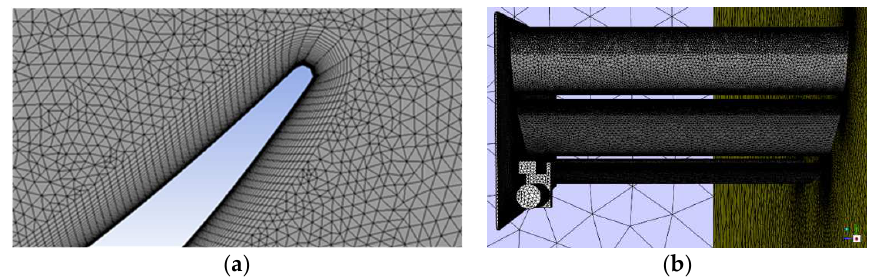
Figure 4. Example of the mesh detail: ( a ) trailing edge of 2D profile and ( b ) 3D rear wing with actuator.